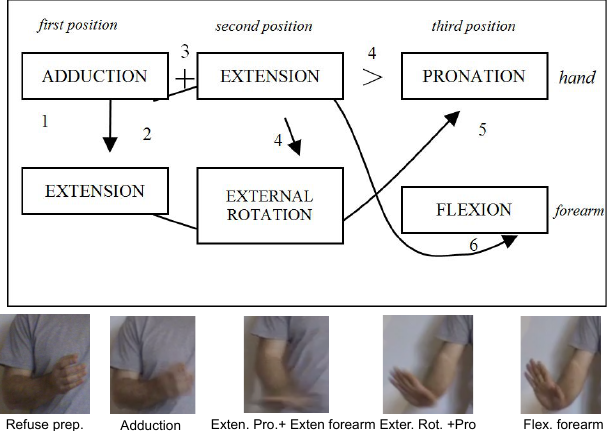
Figure 3. Action schema for the GU "refuse" . This gesture begins with a movement of the hand (Adduction, 1). The order of the motion is numbered. The photograms illustrate the execution of the gesture at different moments of what is gathered in the action schema. The first photogram capture the preparation phase before the stroke.